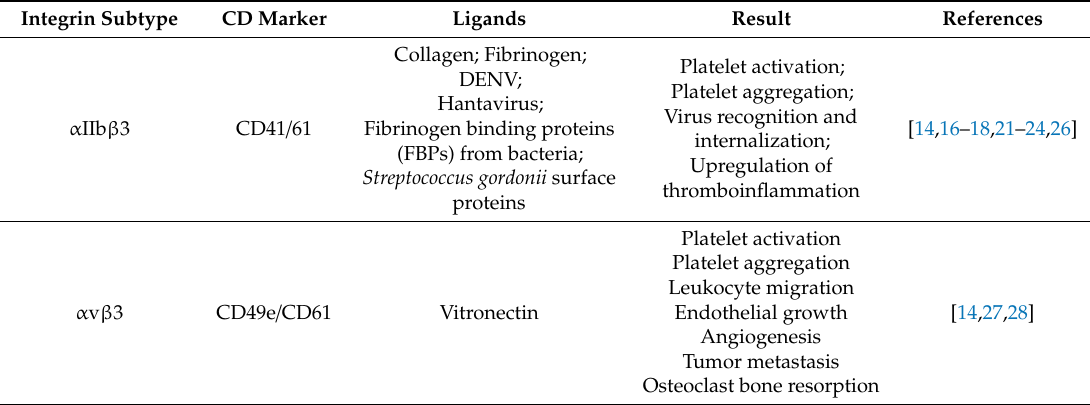
Table 1. Types of β 3 integrins on platelets with a known role in